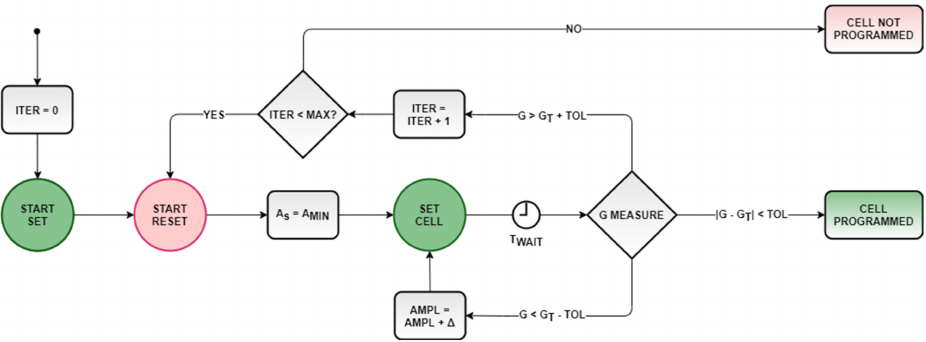
Figure 16. Proposed cells iterative programming algorithm. G indicates the measured cell conduc- tance and G T denotes the conductance target.